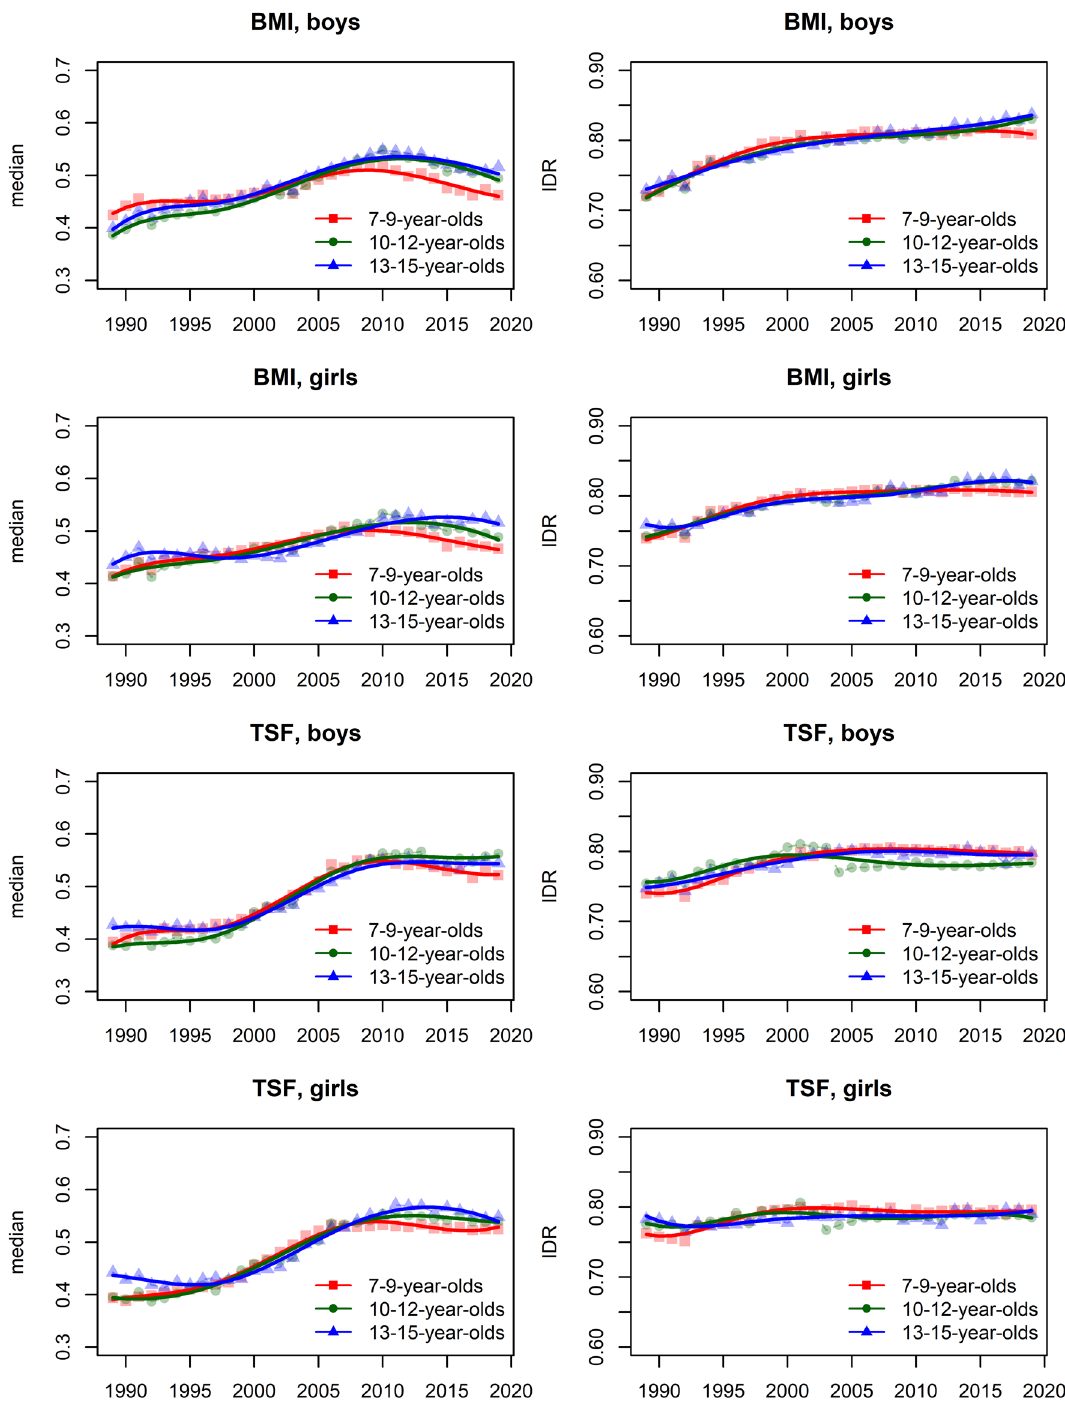
Figure 2. Time trends (medians and IDR) in the BMI and TSF between 1989 and 2019 by gender, across three age groups: 7–9 years, 10–12 years, and 13–15 years. Points and solid lines are the estimated values and smoothed estimated values, respectively, adjusted by region (the results are shown fixing the region to its mode). In the plots showing the estimated medians, the estimates above (below) 1/2 imply that the results were larger (smaller) than in the period 1989–2019 when comparing children of the same gender and age. See Supplementary Information for more results including the uncertainty in the point